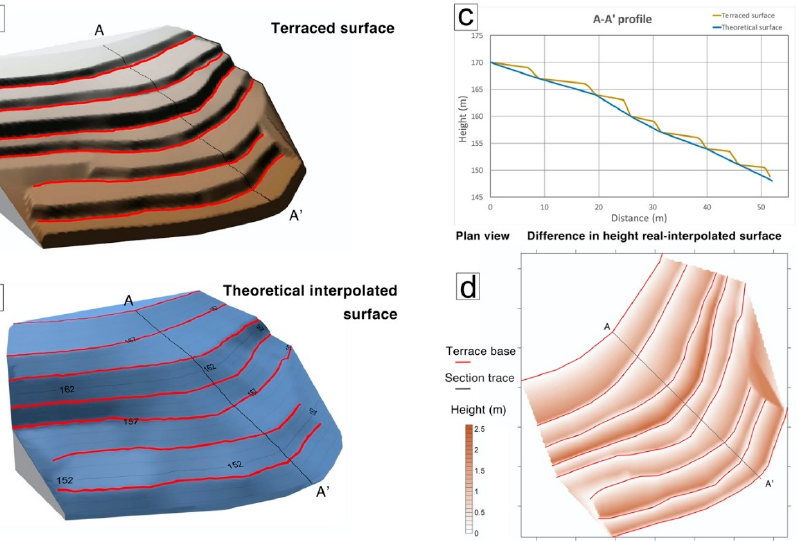
Figure 5. The approach for the volume calculation. ( a ): Terraced surface with the dry-stone wall’s basis identification (red lines); ( b ): the theoretical surface obtained through the interpolation of wall’s basis; ( c ): the profile along the AA’ lines comparing surfaces 1 and 2; ( d ): the DTM of differ- ences obtained by subtracting surface 2 from 1.